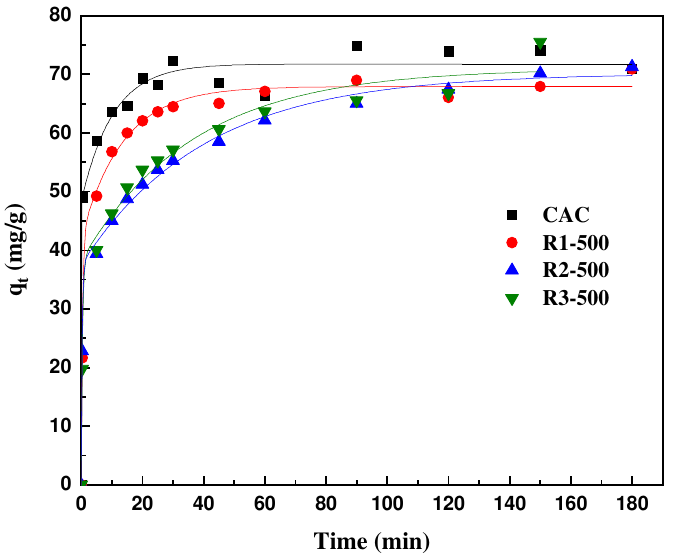
Figure 4. Adsorption kinetics of atenolol on different activated carbons at 25 °C, initial concentration C 0 = 50 mg/L; adsorbent concentration = 50 mg/L (experimental data: symbols; and second-order adsorption kinetic equation: continuous line).